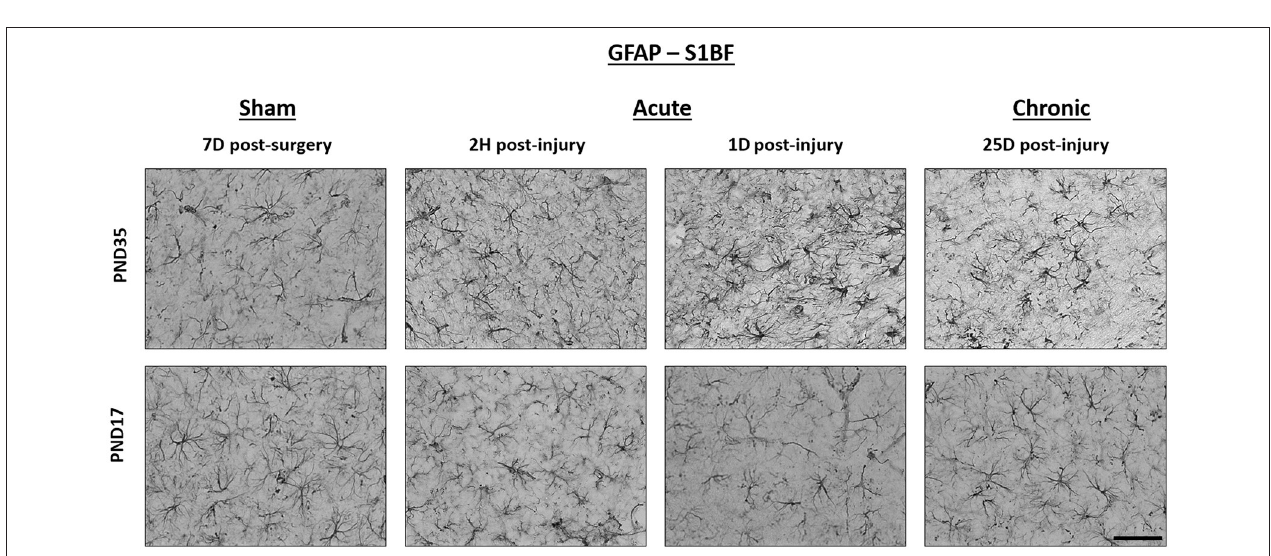
FIGURE 6 | TBI caused no detectable difference in GFAP expression in PND17 or PND35 rats. Immunohistochemistry was used to examine GFAP expression. Representative images shown are from both PND17 and PND35 injured rats at 7 days post-sham surgery and 2 hours (H), 1 day (D), and 25D post-injury. All representative images are from the S1BF. Scale bar = 50 µ m. (sham n = 39, TBI n =